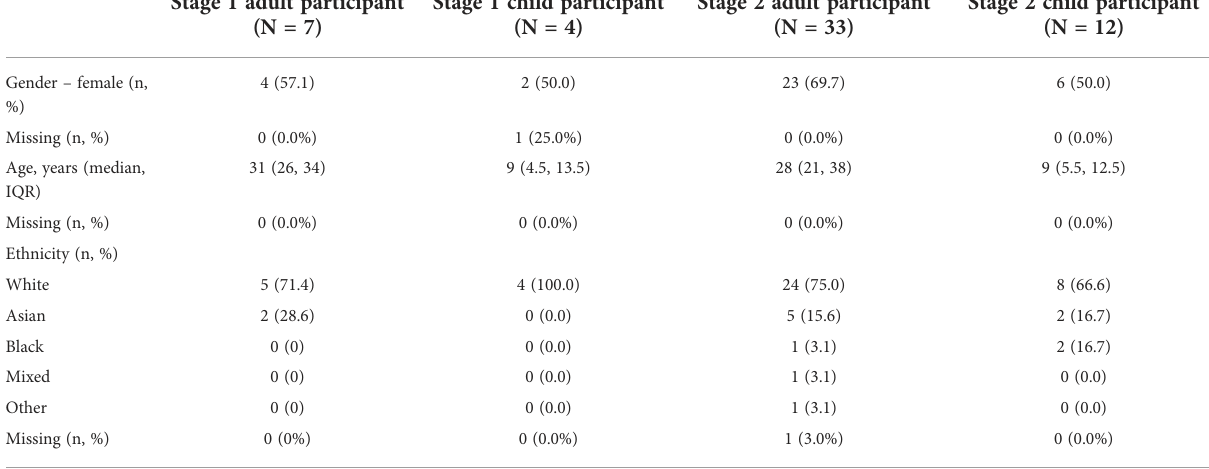
TABLE 1 Characteristics of stage 1 and stage 2 participants.